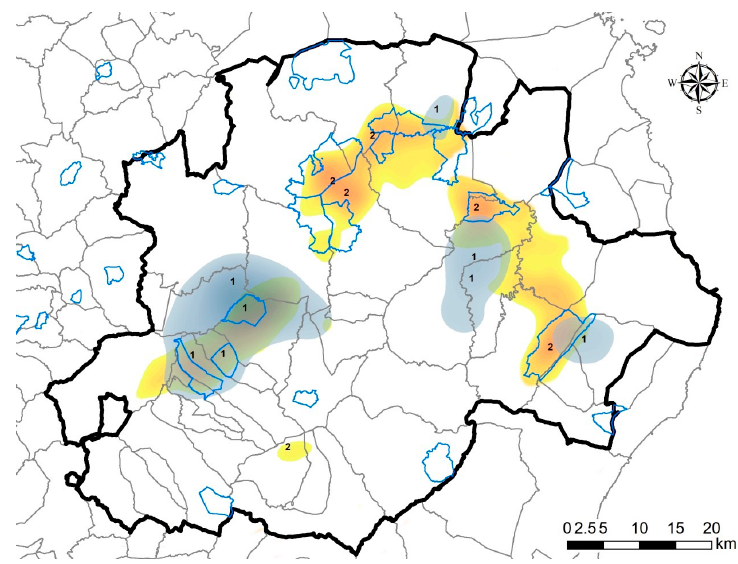
Figure 4. Final passive surveillance map. The grey areas are areas where the probability of finding a pocket of infection is higher (areas 1) given the mixed-effect logistic regression (MELR) model results and the lack of information. The areas indicated as number 2 are areas where the lack of information is higher but not indicated by the MELR models. The blue lines indicate the limits of the protected forest where hunting is forbidden.